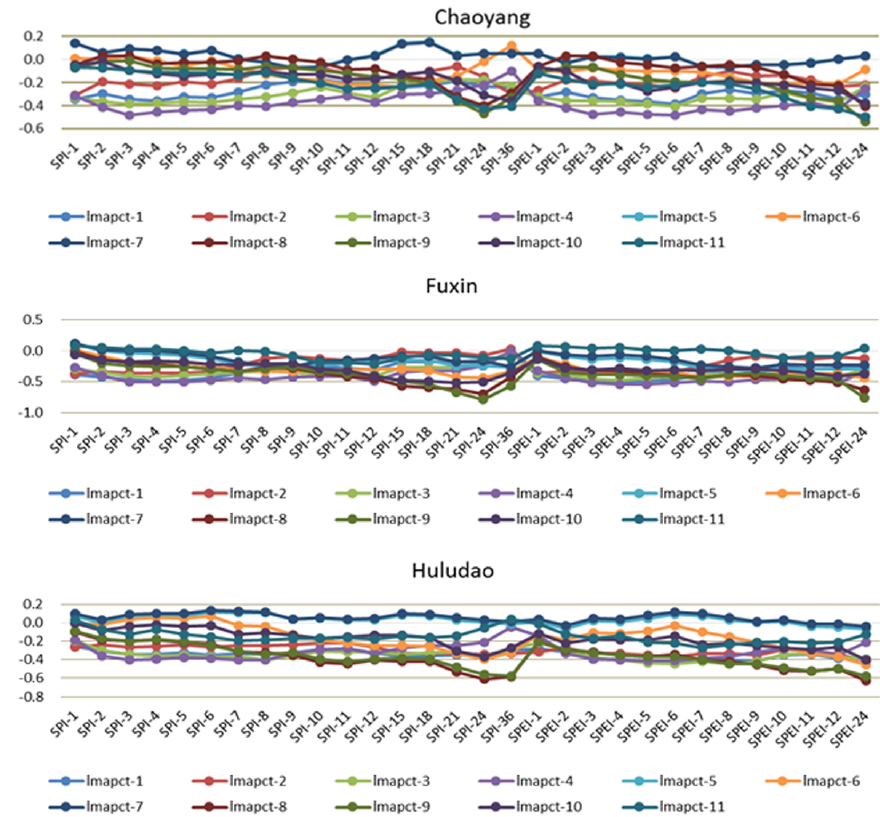
Figure 2. Correlations between SPI/SPEI with different accumulation periods and the 11 drought impact indices in Chaoyang, Fuxin and